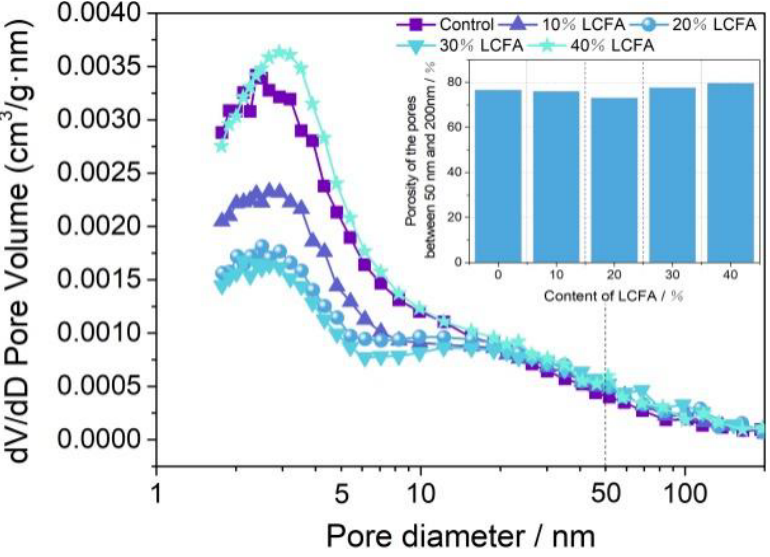
Figure 20. Pore diameter distribution of OPC-LCFA samples at 28 days.